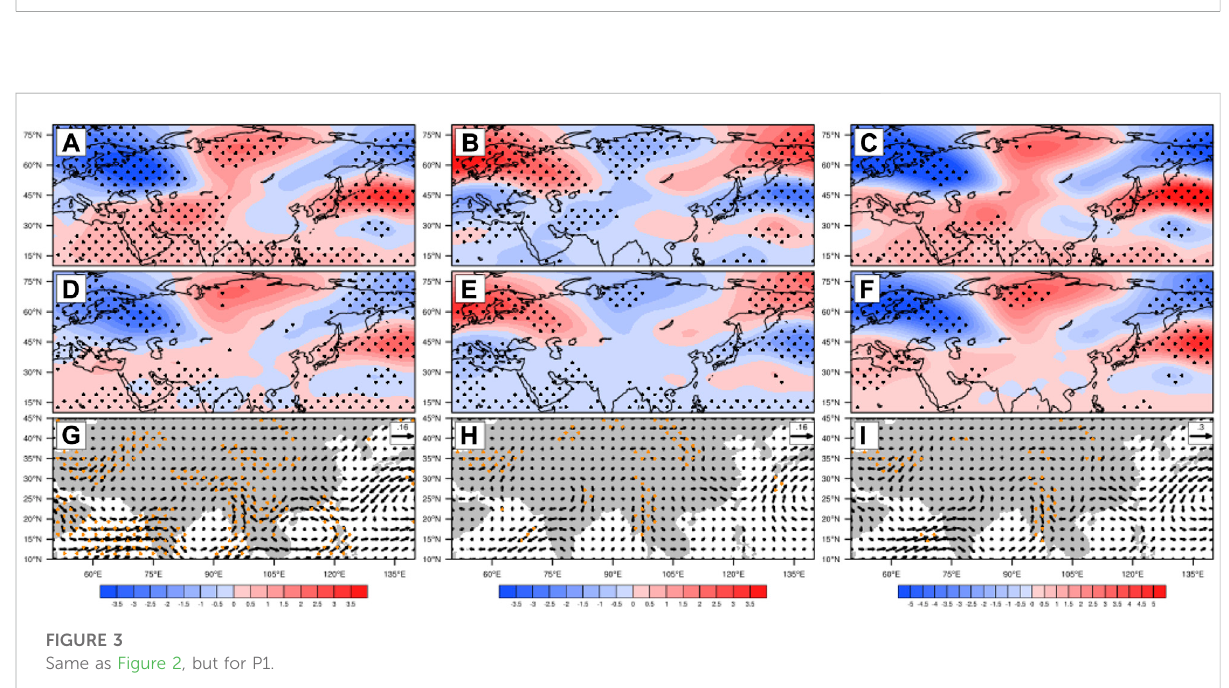
FIGURE 3 Same as Figure 2, but for